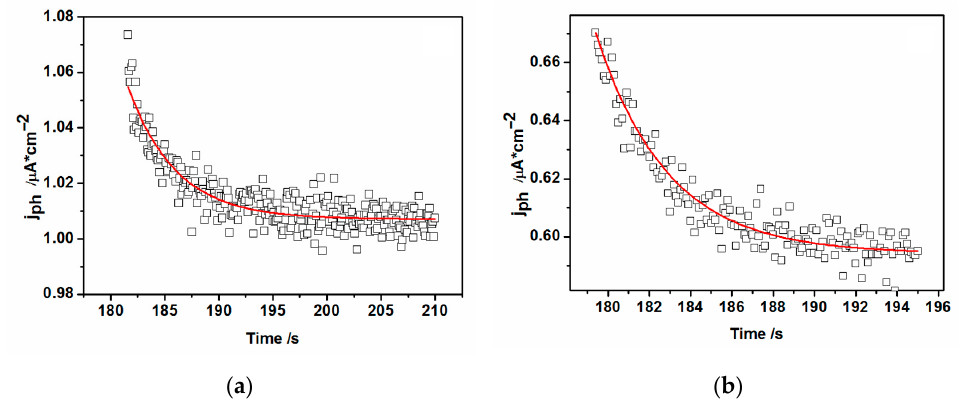
Figure 13. The transients of photocurrent overshoots (spikes) at ( a ) V = − 0.7 V and at ( b ) V = − 0.9 V (vs. MSE) for the case of 50 Langmuir-Blodgett layers. Experimental data (empty symbols) taken from Figure 8b.